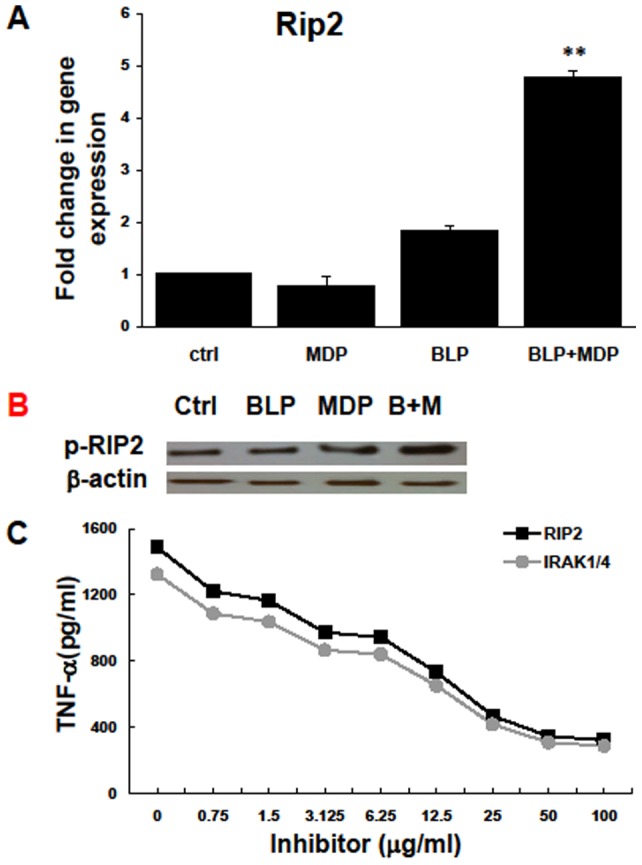
MDP plus BLP increases Rip2 kinase expression.(A) RACs were treated as described in Fig. 2 for 24 h, then the cells were collected and Rip2 mRNA levels determined by RT-qPCR. **, p<0.01, compared with RAC treated with medium, BLP or MDP alone in one-way ANOVA (B) RACs were treated for 15 minutes with medium, BLP, MDP or BLP+MDP, and then the cells were harvested for protein extraction and Western blot analysis using anti-phospho-Rip2 (Ser176) or anti-β-actin antibodies. (C) RACs were pre-incubated with medium alone or medium containing an inhibitor of Rip2 or IRAK1/4 at the indicated concentration for 2 h, then were incubated with BLP plus MDP for 24 h and the supernatant collected for TNF-α measurement by ELISA. The data presented are the mean value (+SD) for triplicate samples for each concentration.